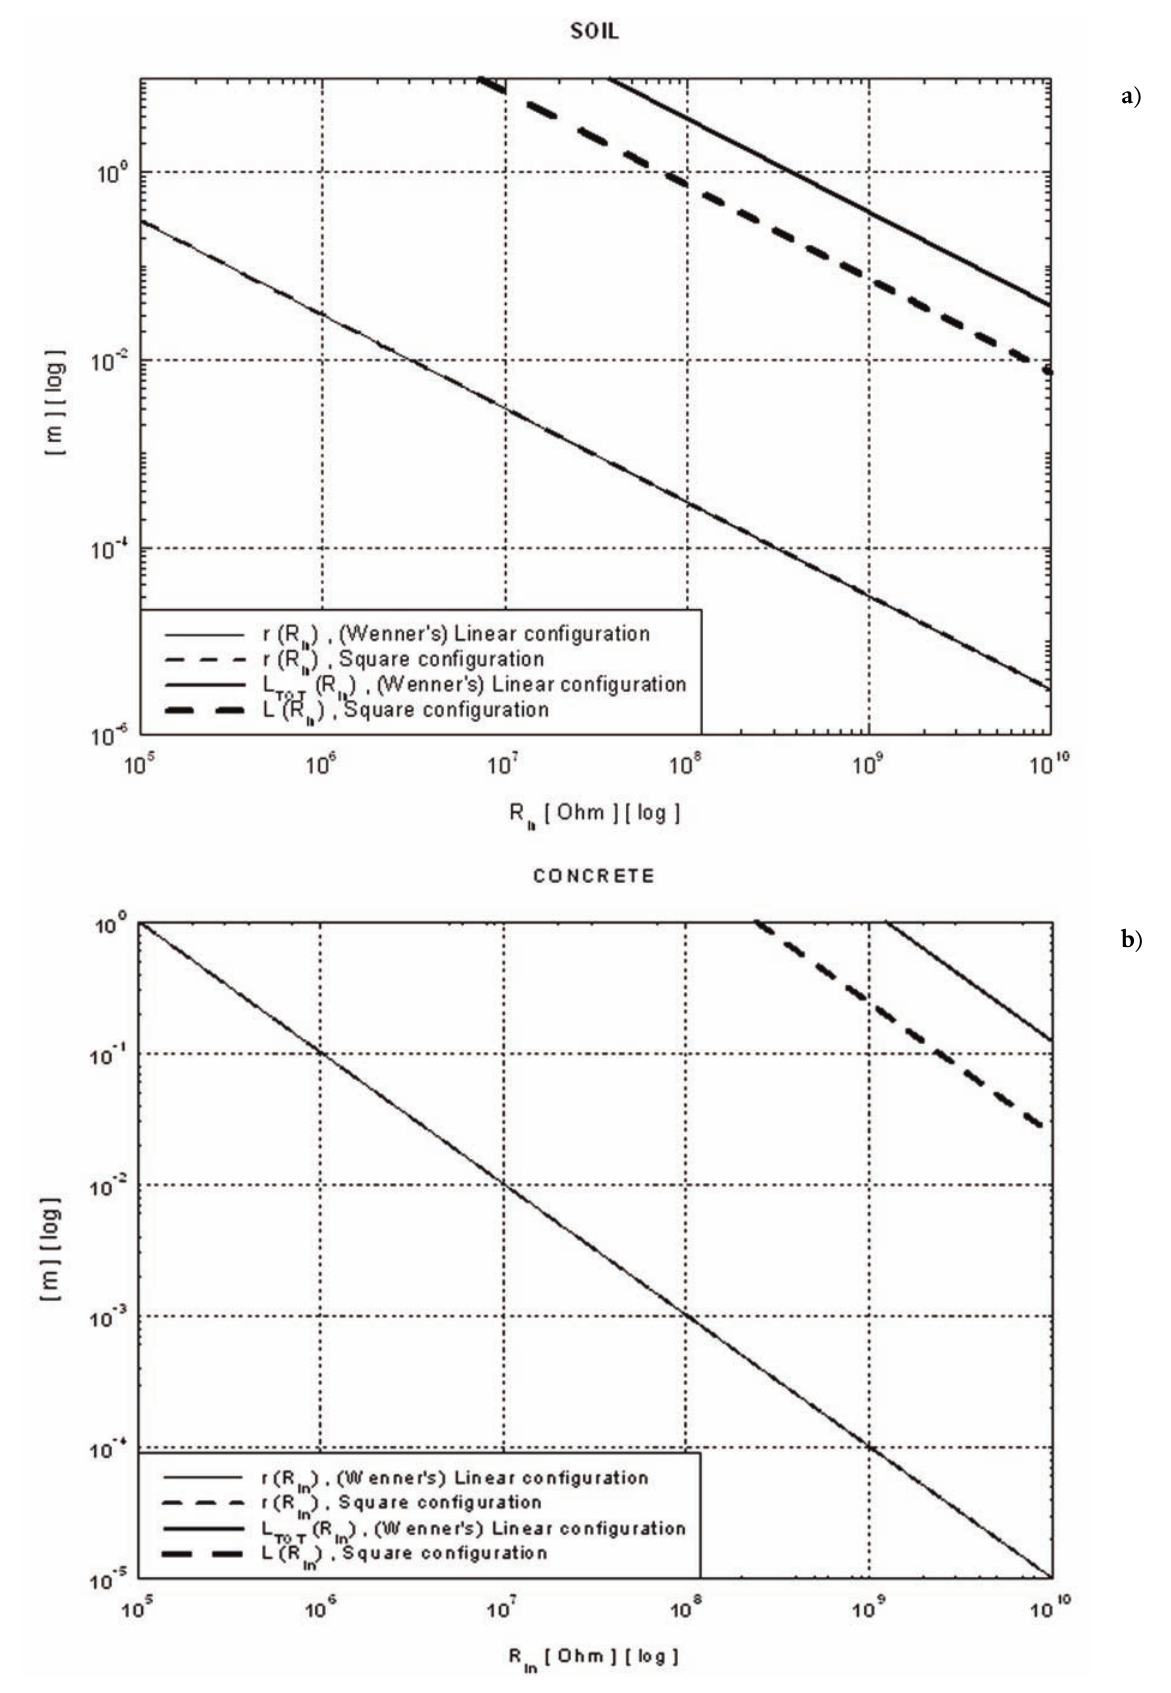
Figure 7. With reference to the operating conditions described in the caption to Figure 2 (for quadrupolar probe); the quadrupole is connected to an IQ sampler of minimum bit resolution n =12 that allows inaccuracies in the measurements below a prefixed limit (10%) within the band [ f min to B =100 kHz. Like-Bode's diagrams of the radius r ( R , f ) for probe electrodes and of the characteristic geometrical minimum value of frequency f min in min dimension L ( r , n ) for square and of the length L ( r , n )=3· L ( r , n ) for (Wenner's) linear configurations, plotted as functions of the input resistance S min TOT min W min R for the amplifier stage, for nonsaturated terrestrial soil (a) and concrete (b); (Table in